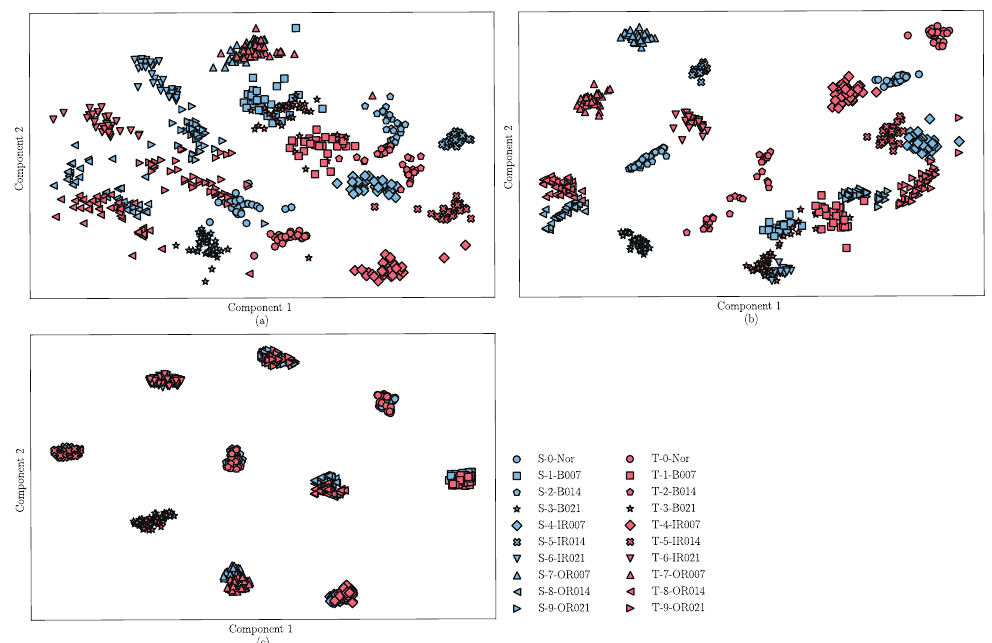
Figure 11. Feature visualization of different methods for the CWRU dataset: ( a ) DANN, ( b ) ADDA, and ( c )